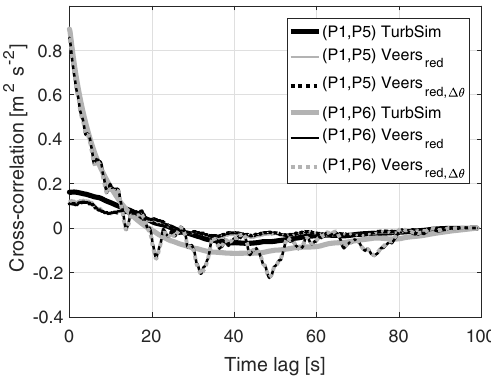
Figure 7. Wind speed cross-correlation for two point pairs gener- ated from different models: a close pair ( P 1 , P 6 ) and a distant one ( P 1 , P 5 ).